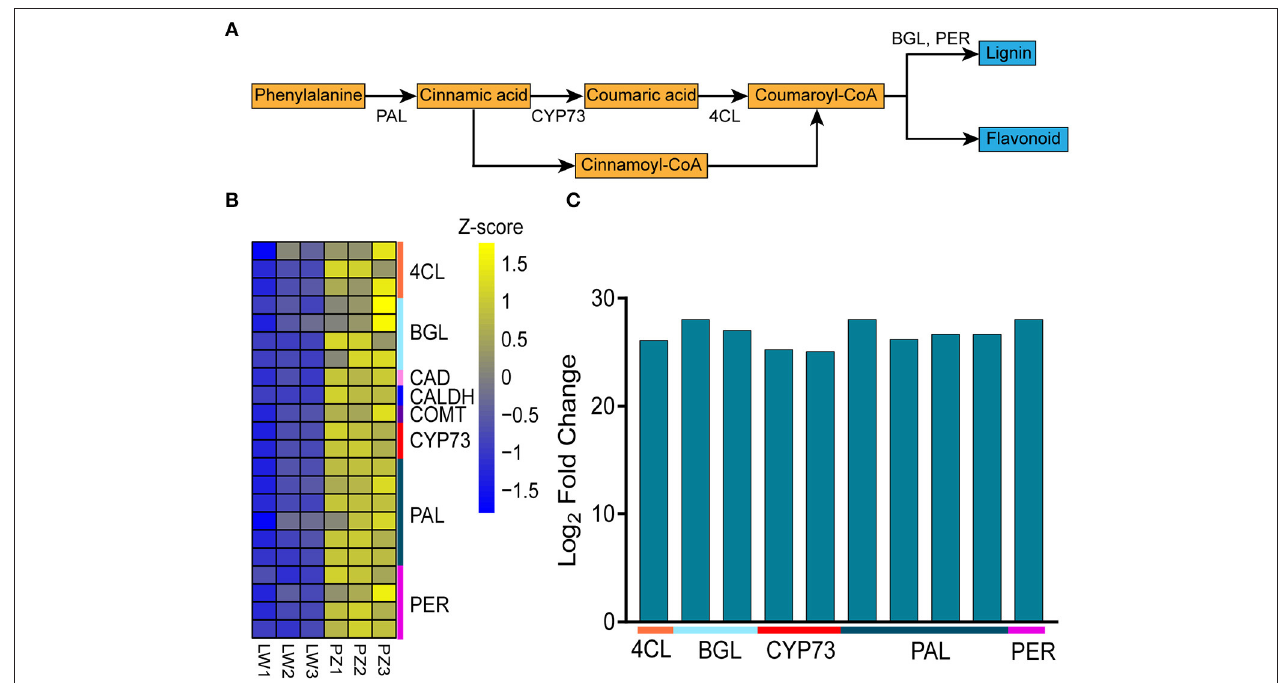
FIGURE 4 | Differentially expression genes involved in Phenylpropanoid biosynthesis. (A) The key genes of Phenylpropanoid biosynthesis. (B) Expression patterns of differently expressed genes (DEGs) involved in Phenylpropanoid biosynthesis. The DEGs are 4-coumarate—CoA ligase (4CL), beta-glucosidase (BGL), cinnamyl-alcohol dehydrogenase (CAD), caffeic acid 3-O-methyltransferase (COMT), trans-cinnamate 4-monooxygenase (CYP73A), phenylalanine ammonia-lyase (PAL), peroxidase (PER), and coniferyl-aldehyde dehydrogenase (CALDH). (C) Differentially abundance proteins (DAPs) involved in Phenylpropanoid